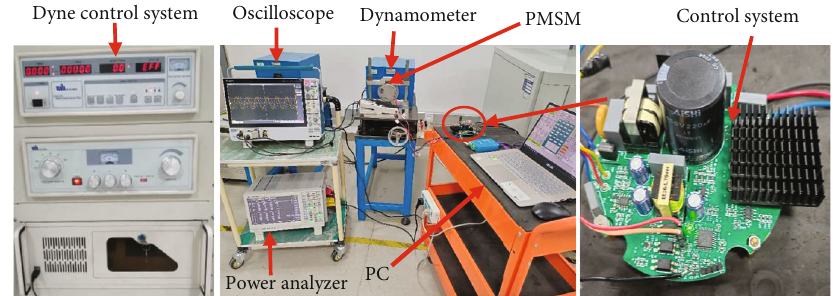
Figure 29: Experimental